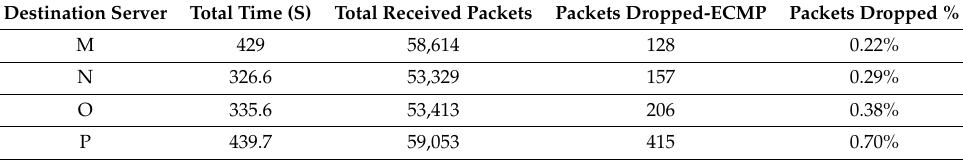
Table 7. Number of dropped packets for the ECMP algorithm.